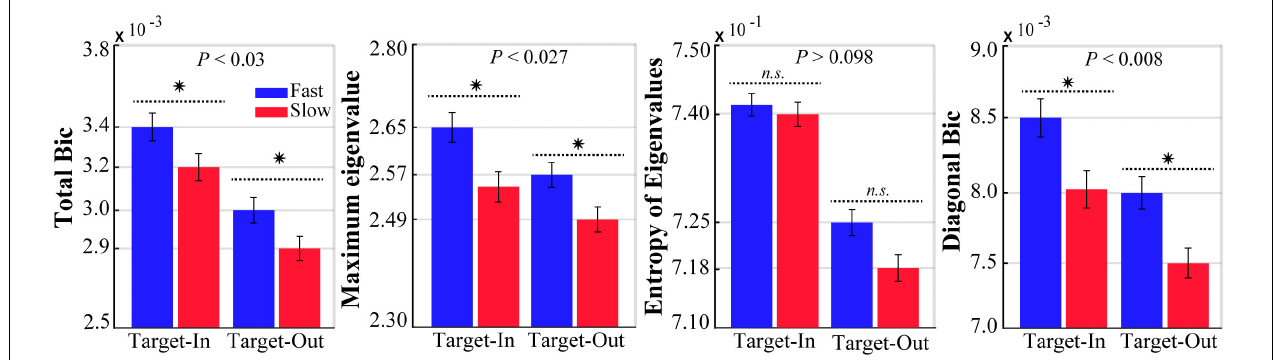
FIGURE 2 | The bicoherence indices for the fast and the slow trials at each target location condition (Target-In\Target-Out). Stars show a significant difference between the bicoherence indexes calculated for the fast (blue) and the slow (red) trials (two-sided Wilcoxon rank-sum test, P -values have been reported on top of the bars). Error bars indicate